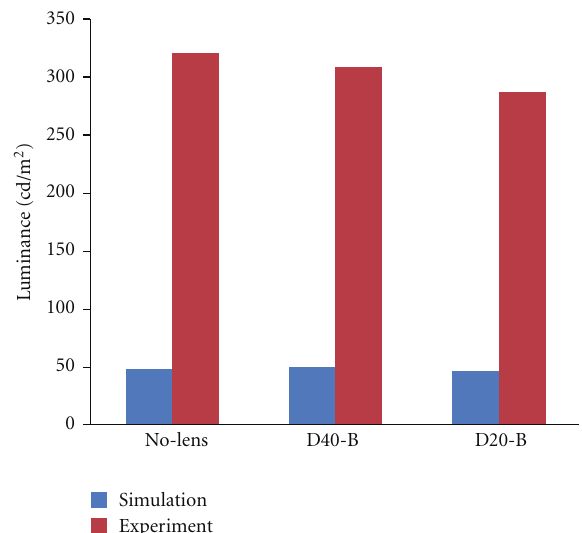
Figure 26: Comparison of the average luminance.